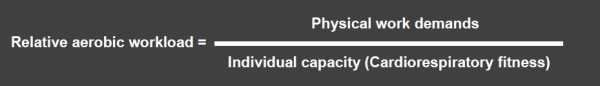
Conception of the relative workload.